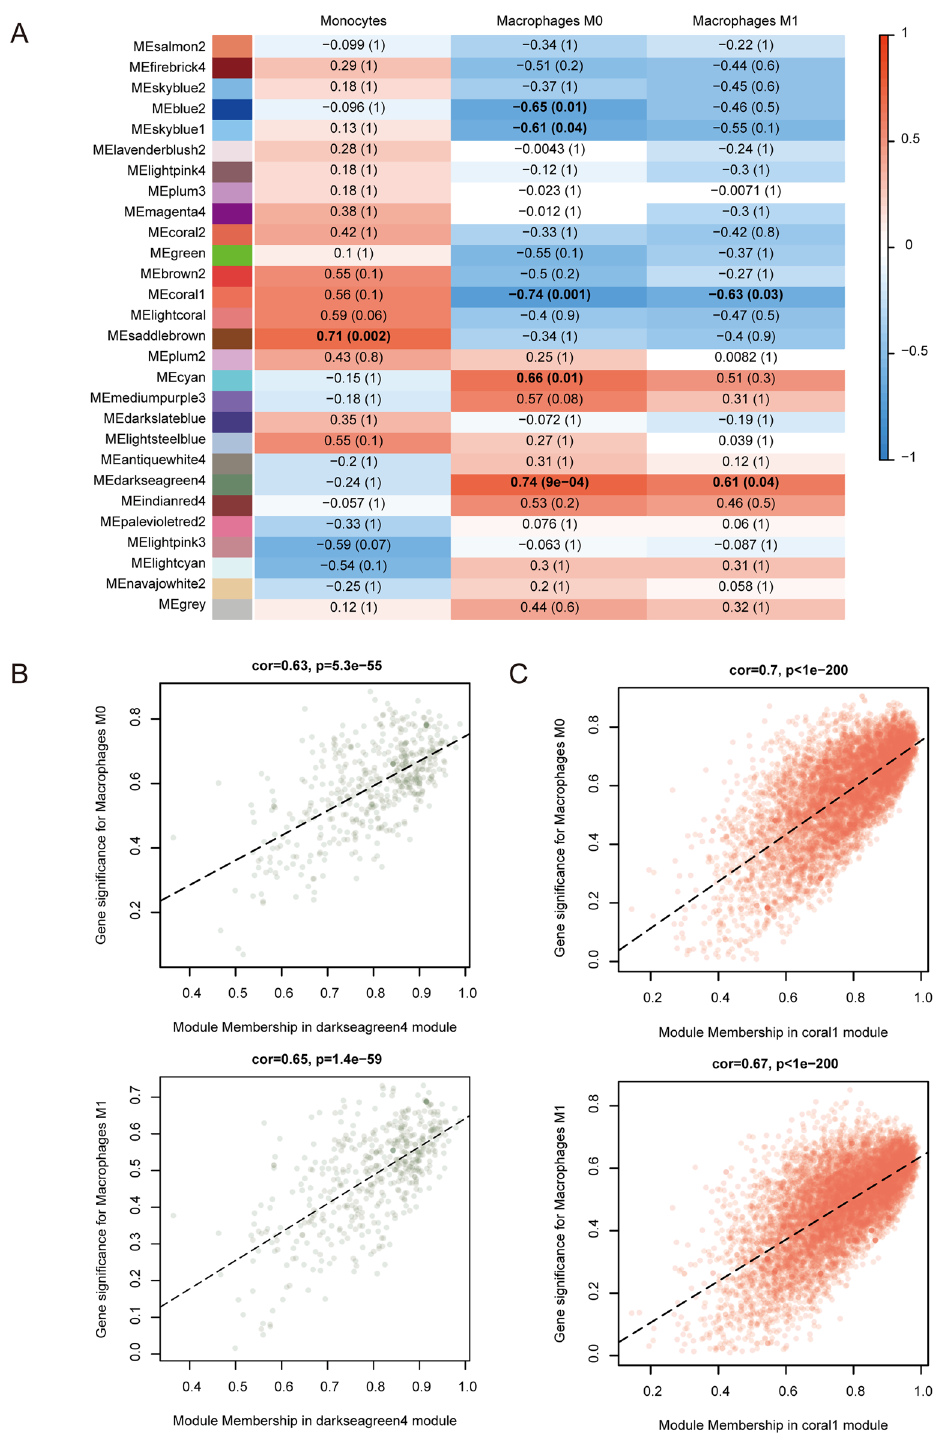
Figure 8. Correlation analysis between M0 and M1 macrophages, and key gene expression modules. ( A ) The heat map revealed that variations in M0 and M1 macrophages were associated with coral1 and darkseagreen4 modules, with corresponding correlation and p -value in each cell. ( B ) The scatter plot revealed that Gene significance (GS) and module membership (MM) are highly correlated in coral1 and darkseagreen4